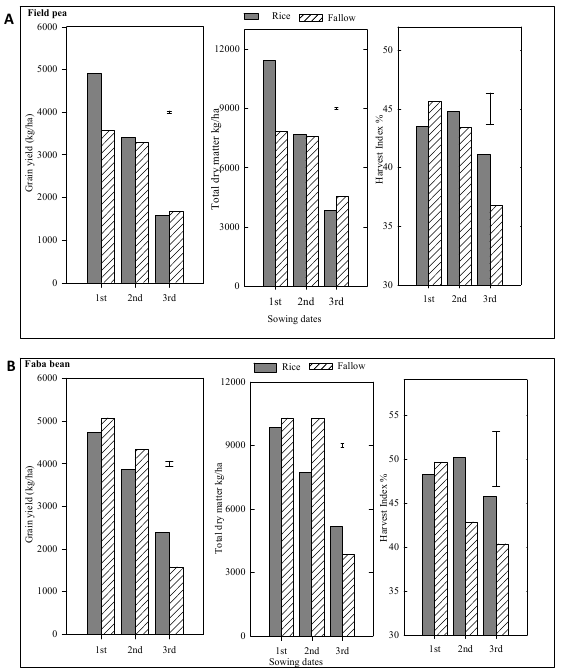
Figure 6. Grain yield, total dry matter and harvest index for field pea ( A ) and faba bean ( B ) grown after rice and after fallow soils at three sowing dates (S1 sowing) S1, (S2 sowing) S2 and (S3 sowing) S3. The harvest index is the ratio between grain yield and total dry matter. Vertical error bars represent LSD values at the 0.05% level of significance. Agronomy 2016 , 6 , 47